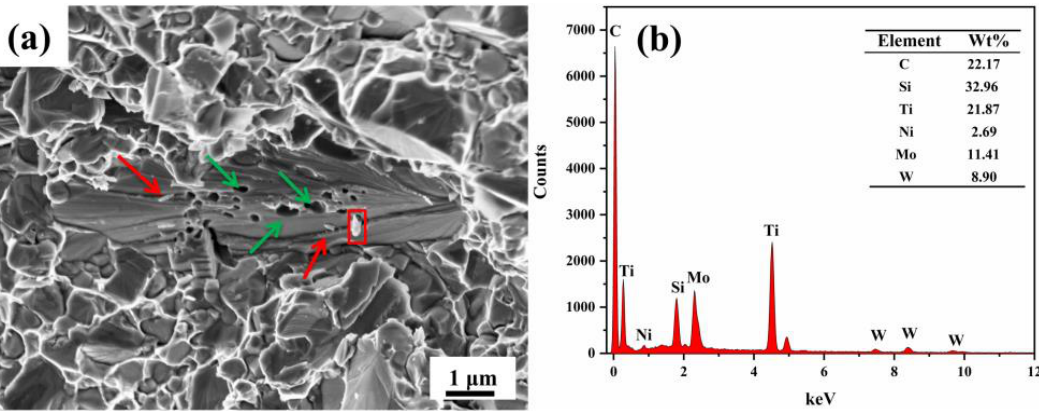
Figure 12. ( a ) The fracture surfaces of cermets F with 2.0 wt.% SiC w ; ( b ) EDS scanning results.